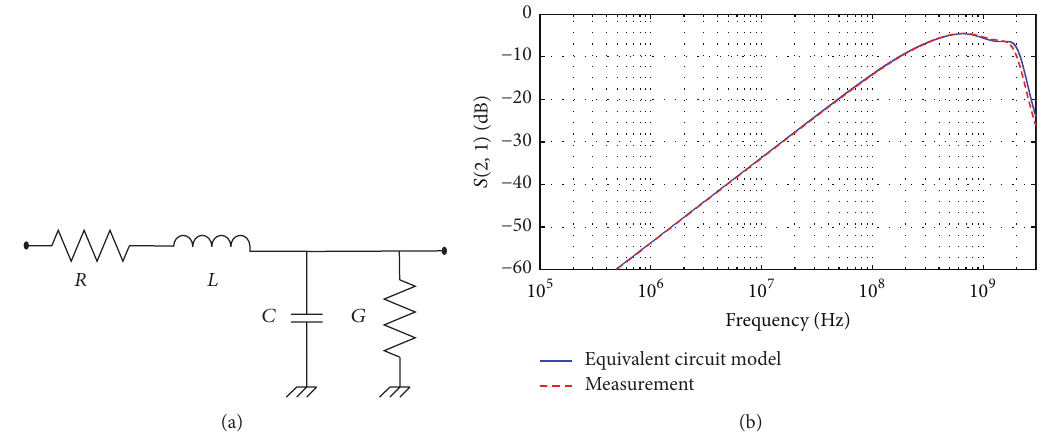
Figure 12: Validation of PCB equivalent circuit model including DPI capacitor. (a) Equivalent circuit model of a segment. (b) 𝑆(2, 1) comparison.